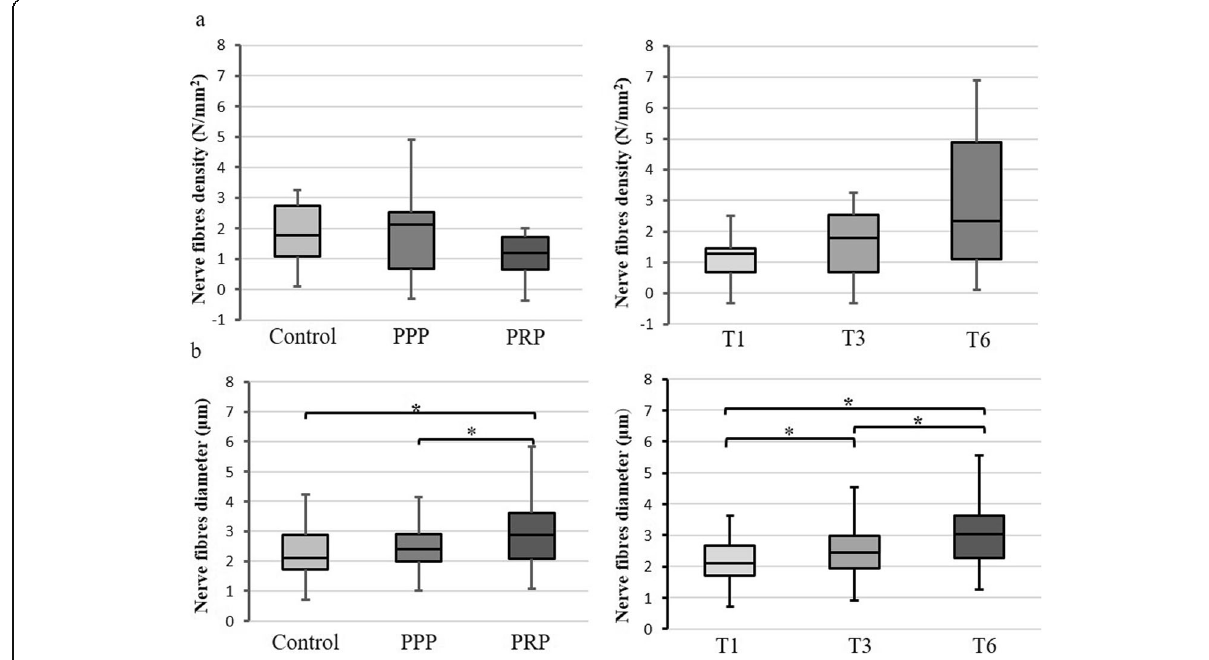
Fig. 5 Box plots of nerve fiber density ( a ) and shortest diameter ( b ) for groups (control, platelet-poor, and platelet-rich plasma) and healing time (1, 3, and 6 months). The boundary the closest to 0 indicates the 25th percentile, a black line within the box marks the median, and the farthest from 0 indicates the 75th percentile. Whiskers above and below indicate the 10th and 90th percentile. No difference was observed in the myelinated nerve density, but a significant difference ( p < 0.05 indicated by an asterisk) was found for the shortest nerve diameter between groups and healing